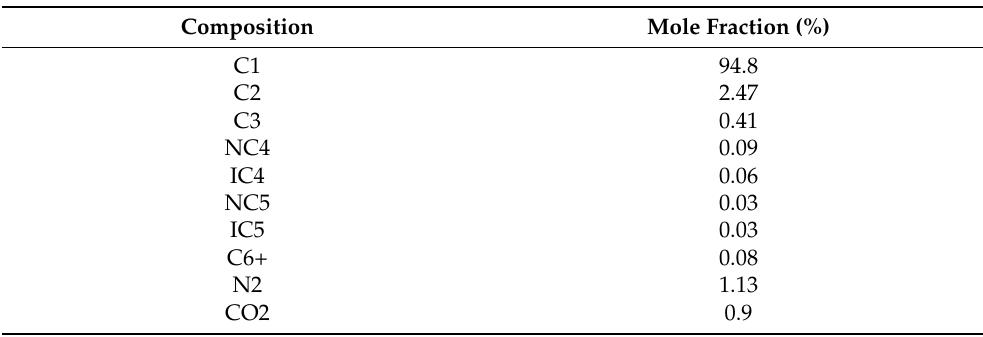
Table 3. Gas composition.